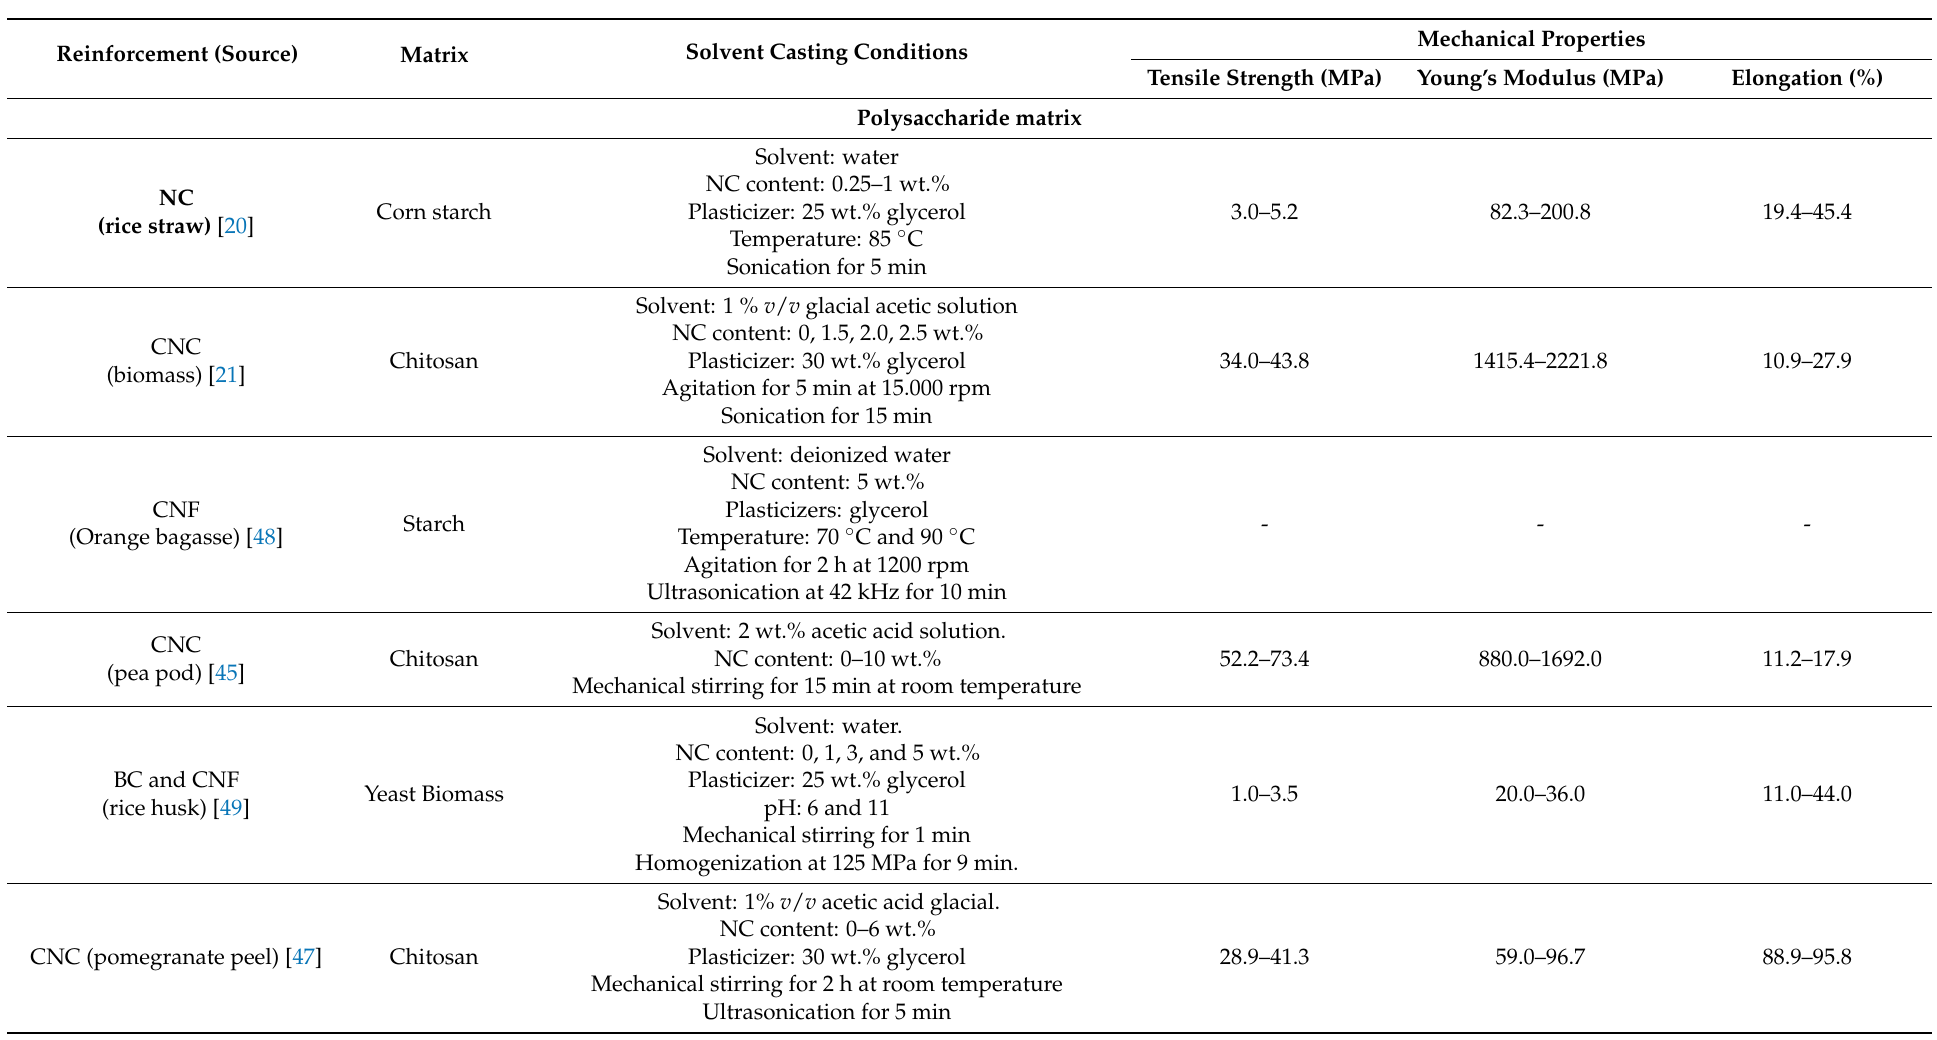
Table 1. Solvent casting processing conditions of nanocellulose biobased